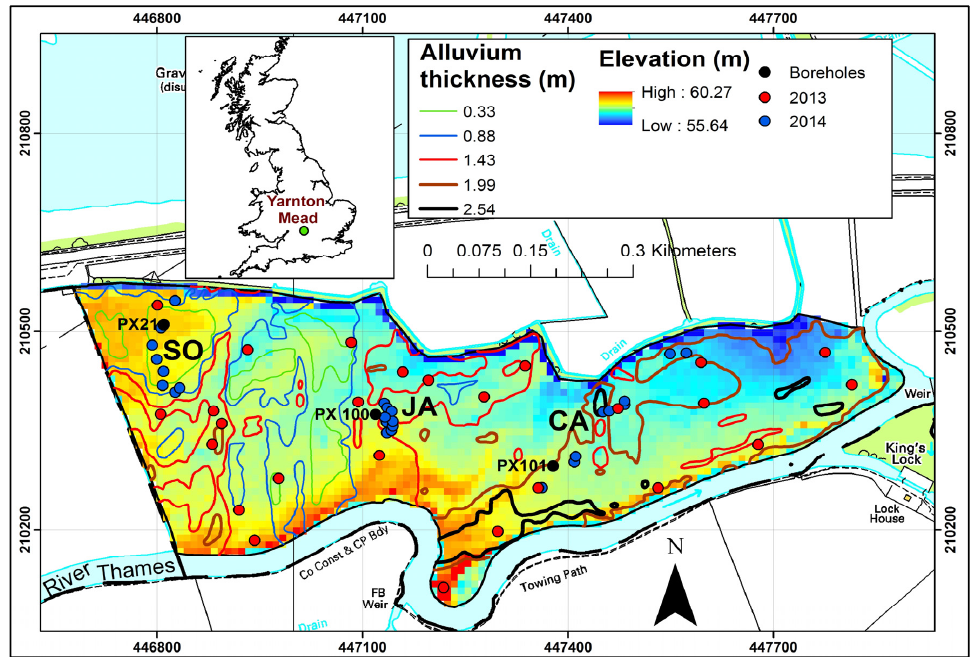
Figure 1. Yarnton Mead with sampling locations for 2013 and 2014, elevation map (from airborne LIDAR survey in June 2014) and alluvium thickness contour lines (Courtesy of Hanson UK), overlaid on Ordnance Survey 1:10,000 scale base-map.